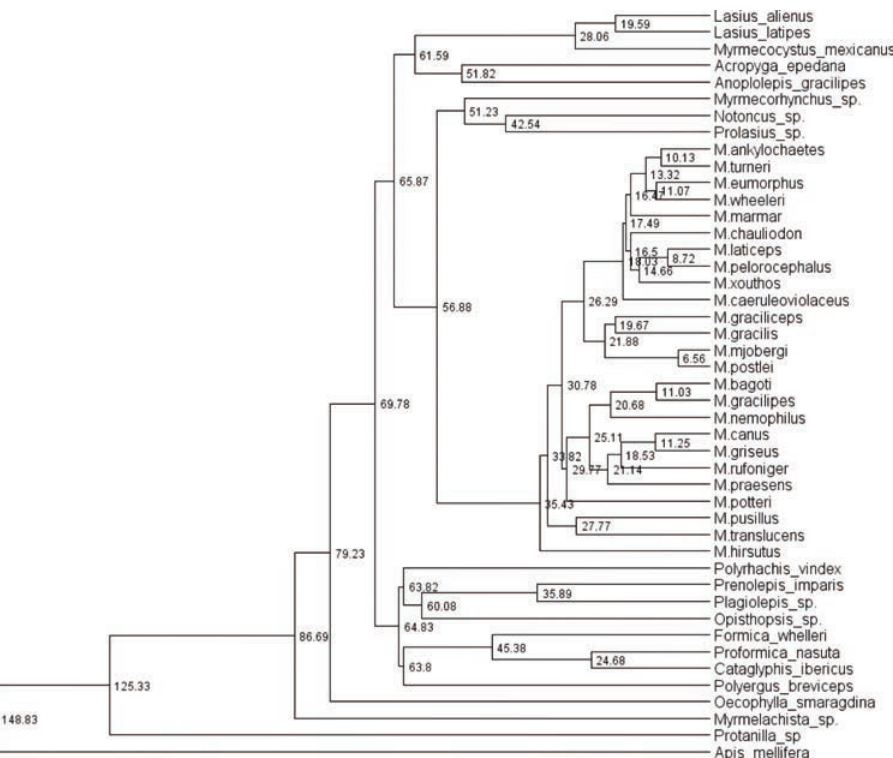
Figure 5. Calculated dates of divergence for TMRCA for Melophorus and other sample formicine taxa, including several of the postulated nearest relatives of Melophorus (i.e., other Melophorini). Outgroups are Apis mellifera and Protanilla